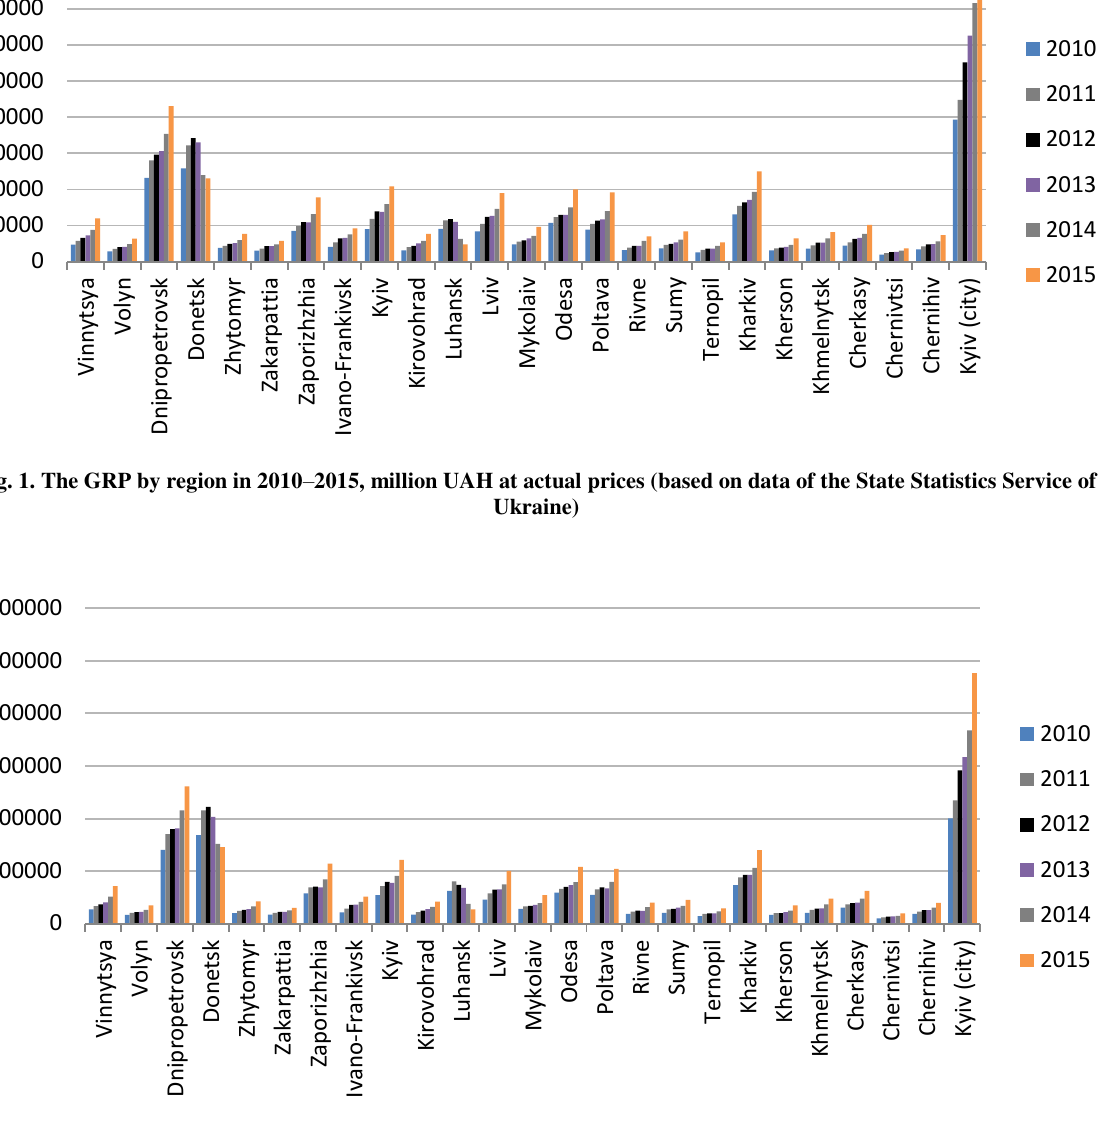
Fig. 2. The output of products and services in Ukrainian regions in 2010 – 2015, million UAH at actual prices (based on data of the State Statistics Service of